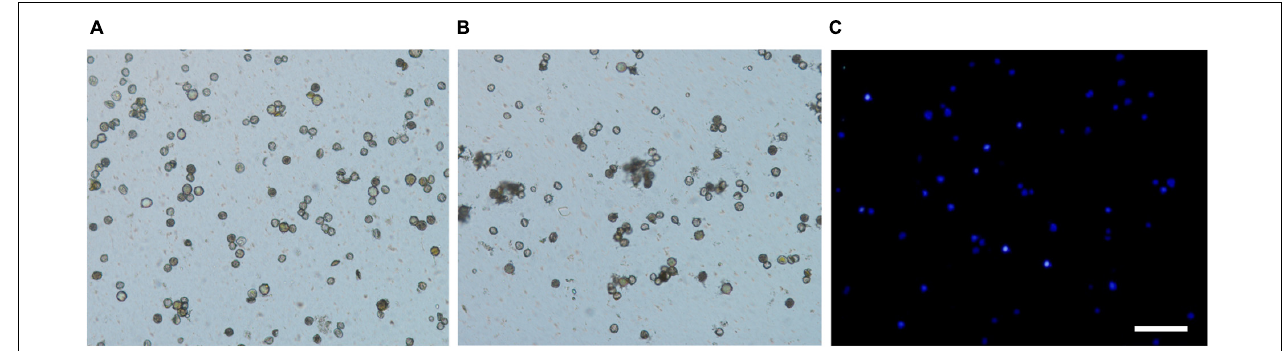
FIGURE 3 | Comparison of nuclei isolation by chopping and grinding methods in kiwifruit. (A) Nuclei extracted by chopping method, (B) nuclei extracted by grinding method, and (C) nuclei extracted by chopping method and stained with 2-(4-amidinophenyl)-1H-indole-6-carboxamidine. The white scale bar represents 100 µ m.